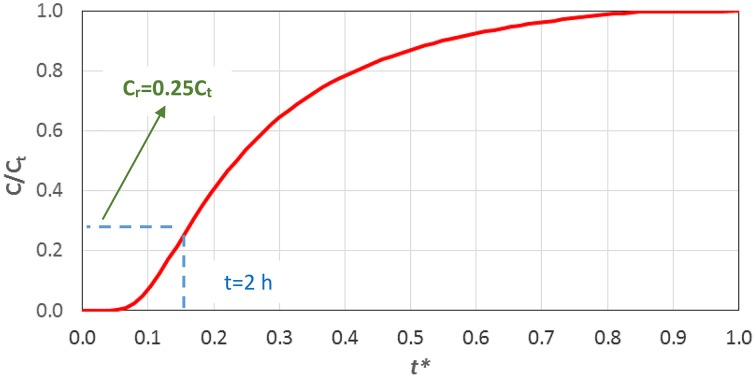
Graphical solution of Equation (6).